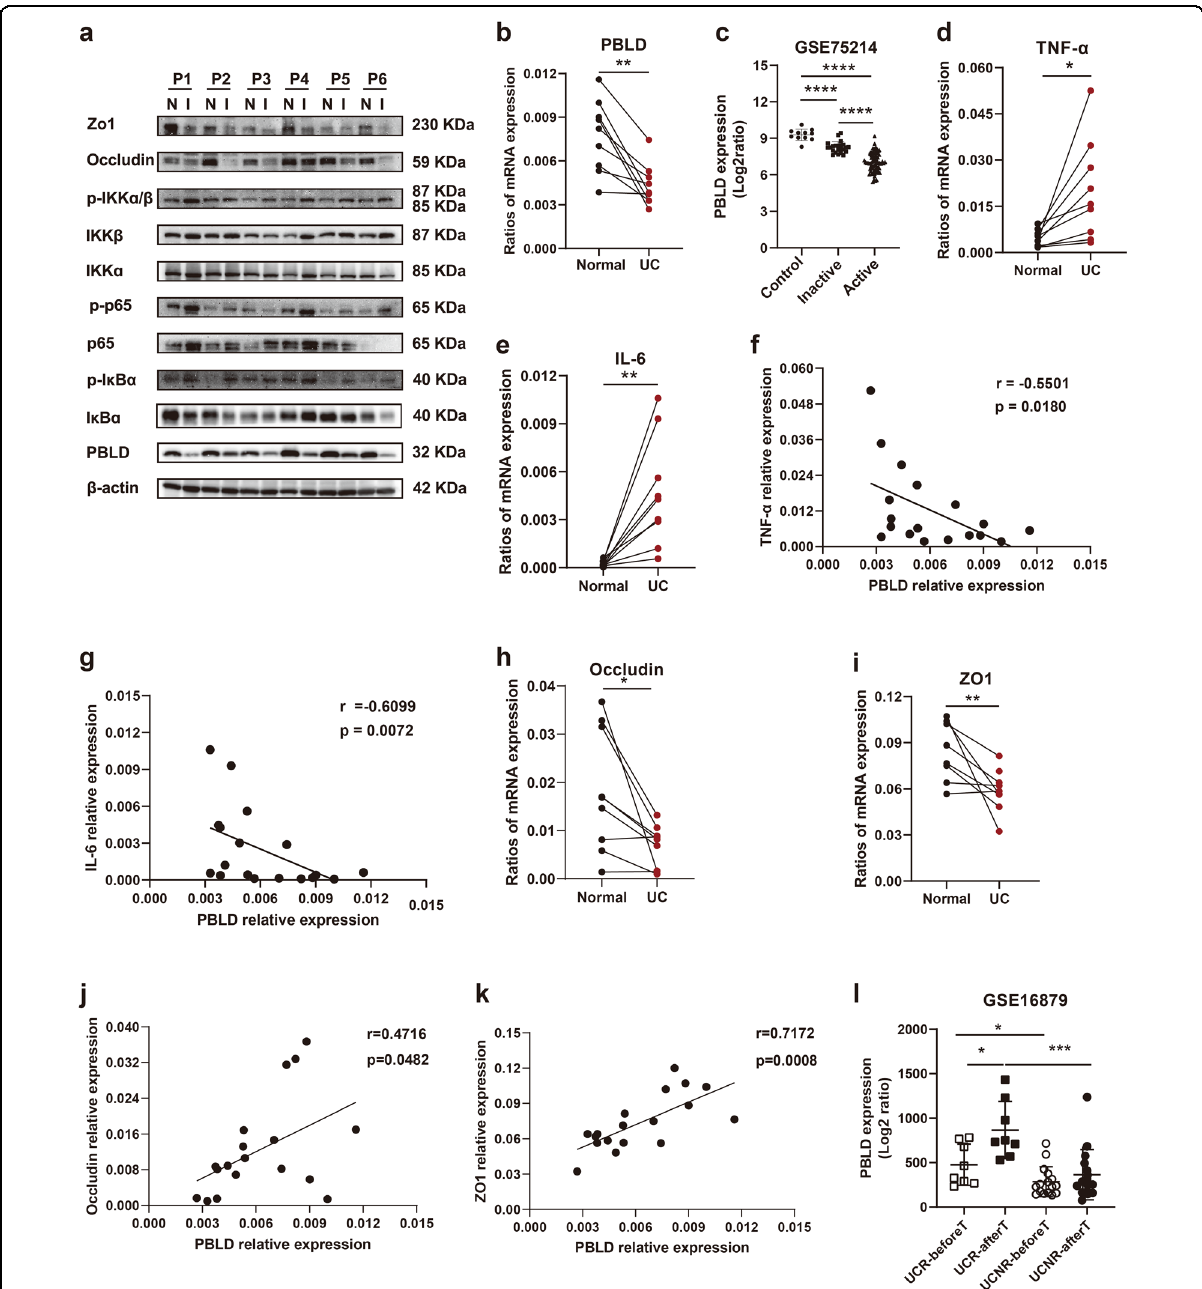
Fig. 1 PBLD is decreased in people with UC. a Expression of PBLD, tight junction (TJ) proteins, and the nuclear factor (NF)- κ B signaling pathway was evaluated by immunoblotting in paired colon tissues from patients with UC ( n = 6). β -actin served as an internal control. N normal colon tissue, I in fl amed colon tissue. b Expression of PBLD mRNA was analyzed by quantitative reverse-transcriptase (qRT)-PCR in paired in fl amed and non-in fl amed colon tissue samples from UC patients ( n = 9). Glyceraldehyde 3-phosphate dehydrogenase (GAPDH) was used as an internal control. ** p < 0.01. c Expression of PBLD mRNA was assessed using a published dataset (GSE75214; N = 108; normal controls, n = 11; inactive UC, n = 23; active UC, n = 74) **** p < 0.0001. d , e Levels of TNF- α and IL-6 mRNA were analyzed using qRT-PCR in paired in fl amed and non-in fl amed colon tissue samples from patiens with UC ( n = 9). f Spearman ’ s correlation analysis between PBLD and TNF- α mRNA levels ( r = − 0.5501, p = 0.0180). g Spearman ’ s correlation analysis between PBLD and IL-6 mRNA levels ( r = − 0.6099, p = 0.0072). h , i Occludin and ZO-1 mRNA levels were analyzed using qRT-PCR in paired in fl amed and non-in fl amed colon tissue samples from patients with UC ( n = 9). j Spearman ’ s correlation between PBLD and occludin mRNA levels ( r = 0.4716, p = 0.0482). k Spearman ’ s correlation between PBLD and ZO-1 mRNA levels ( r = 0.7172, p = 0.0008). l PBLD mRNA levels were analyzed using a published dataset from patients with UC who received in fl iximab treatment. (GSE16879; N = 24; those who responded to treatment, n = 8; nonresponders, n = 16). UCR-beforeT responder before in fl iximab treatment, UCR-afterT responder after in fl iximab treatment, UCNR-beforeT nonresponder before in fl iximab treatment, UCNR-afterT nonresponder after in fl iximab treatment. Of fi cial journal of the Cell Death Differentiation